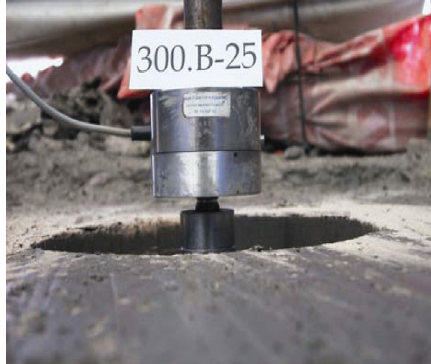
Fig. 6. Installation of bucket foundation ( D = 30 cm, embed- ment ratio 0.25)